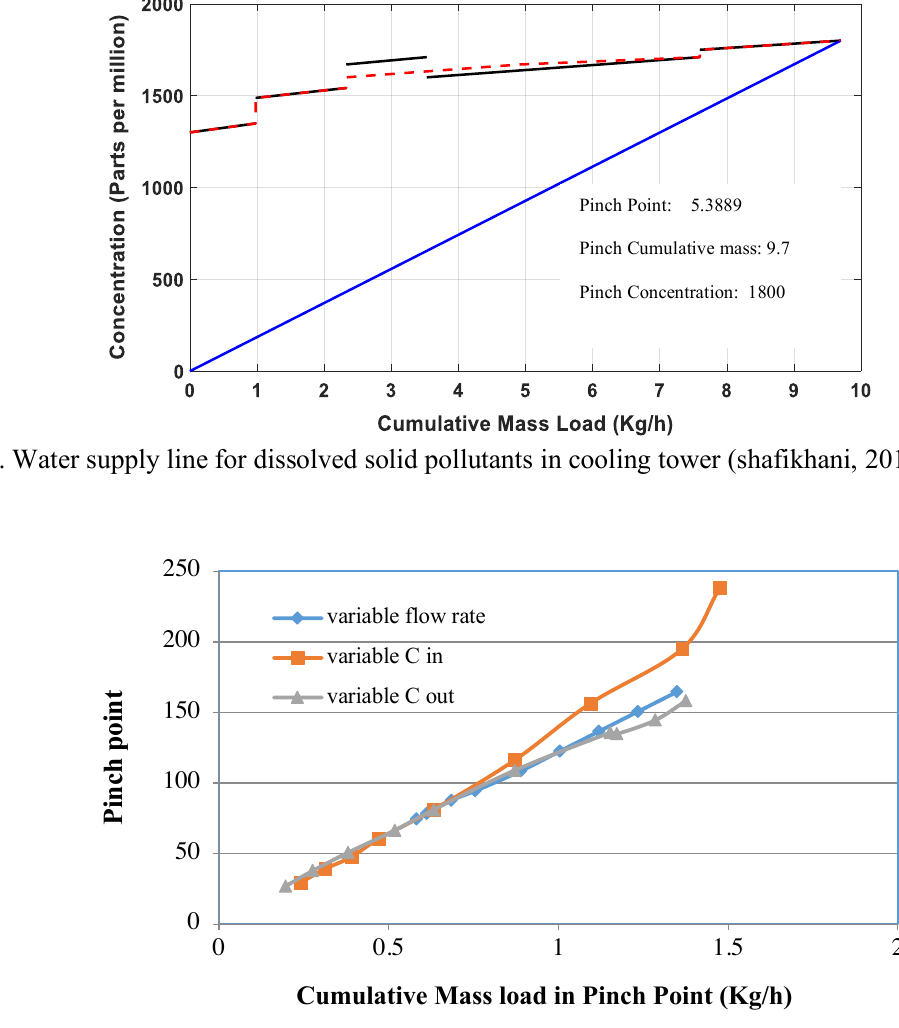
Figure 9. Comparative Diagram for three different